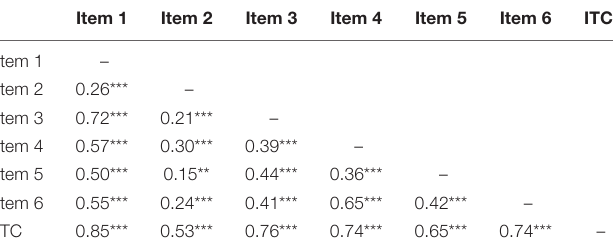
TABLE 4 | French Body Image State Scale items inter-correlations and item-total correlations